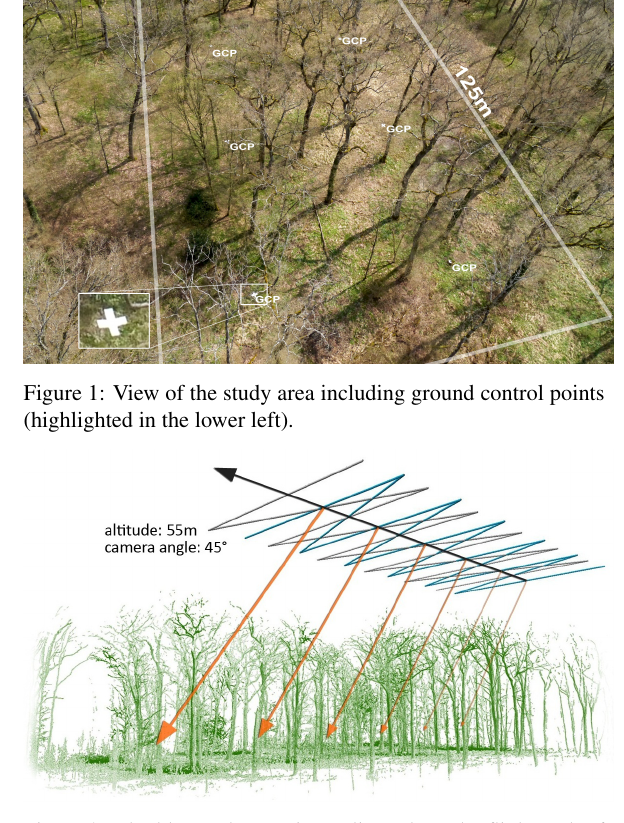
Figure 2: The blue and grey zigzag-lines show the flight path of the UAV. Orange arrows indicate the direction of the camera and the camera angle of